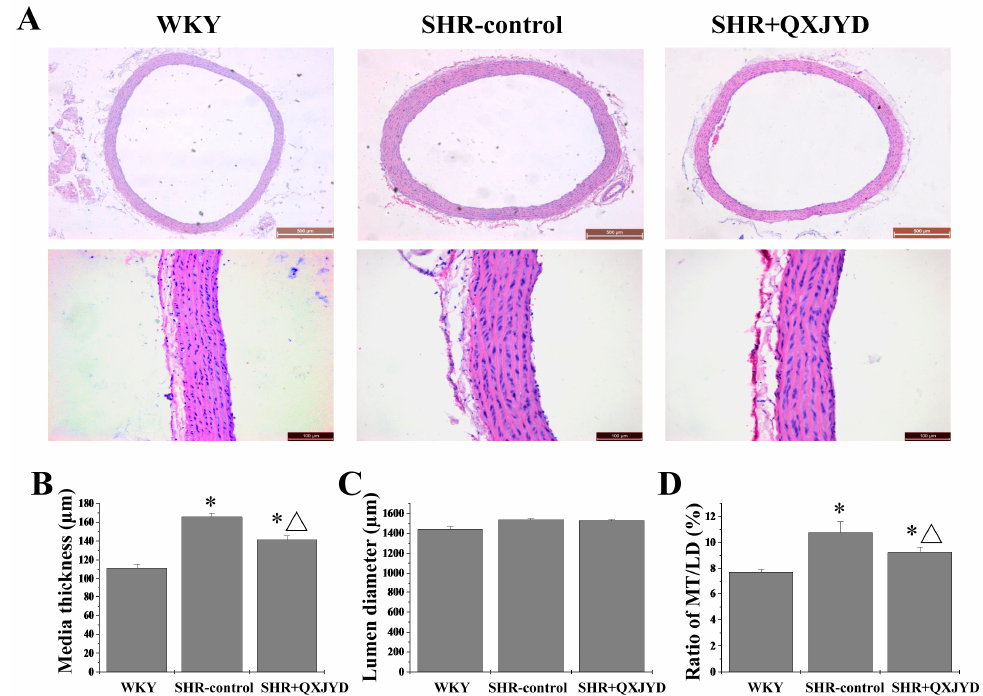
Figure 3. Effect of QXJYD treatment on aortic remodeling. ( A ) Histopathological changes of thoracic aorta in each group ( n = 10) was observed by Harris Hematoxylin and Eosin (H&E) staining. Images were representatives taken at a magnification of 20× (top, scale bar = 500 μ m) or 40× (bottom, scale bar = 100 μ m); ( B ) Media thickness (MT); ( C ) Lumen diameter (LD); and ( D ) MT/LD was measured. All values were represented as mean ± SD; * p < 0.05 compared to WKY group; Δ p < 0.05 compared to SHR-control group.